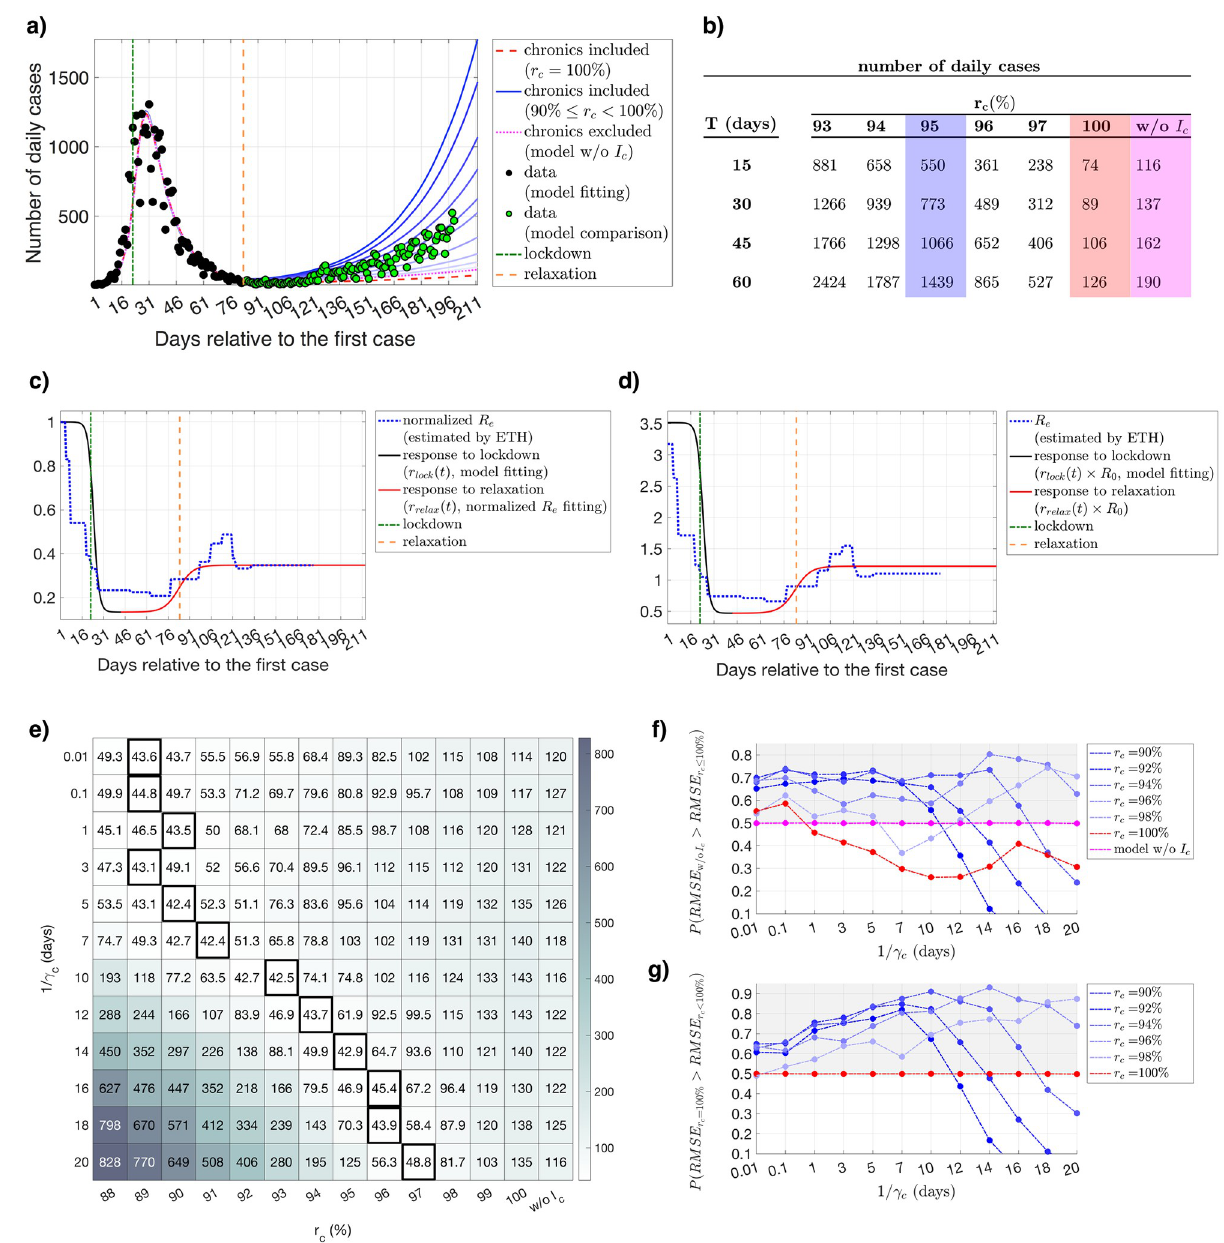
Fig 3. Fitting and prediction results for Switzerland. a) Fitting results and relaxation predictions for Switzerland for the number of daily confirmed cases, calculated using different levels of infectiousness for the chronically infected population, assuming a duration of prolonged infectiousness of 1/ γ c = 14 days. Time dependent effects of the lockdown ( r lock( t ) ) and the relaxation ( r relax( t ) ) are illustrated in c) and d) , respectively. Predictions drawn in darker shades of blue represent the fitting results with increased infectiousness of the chronically infected population, i.e., lower r c values within the range 90 � r < 100%. Fitting results for r = 100% are drawn in red, and the fitting results for the model without the I compartment (model w/o I ) are c c c c drawn in pink. Data points that are used for fitting are drawn in black, and the data points used for comparing the predictive power of different models are drawn in green. e) RMSE values calculated using the prediction results for the number of daily confirmed cases for a given r and γ value, where c c model w/o I c represents the results for the model without the I c compartment. Models with the best predictive power (smallest RMSE value) are indicated by the bold black boxes. f) Probability of the model without the I compartment (model w/o I ) having a greater RMSE value than the model c c with the I c compartment for different levels of reduced infectiousness (90% � r c � 100%) and γ c values, calculated over the predicted data points. g) Probability of the model where individuals are being diagnosed without being infectious ( r c = 100%) having a greater RMSE value than the model with < 100%) for different r and γ values, calculated over the predicted data points. Points in the gray areas individuals with a a prolonged infectiousness ( r c c c represent the models that are providing a better fit more frequently than f) the model without the I c compartment (model w/o I c ) and g) the model with r c = 100%. b) Prediction results of the first 5 models ( r c = {93%, 94%, 95%, 96%, 97%}) with the lowest RMSE value (best predictive power), model